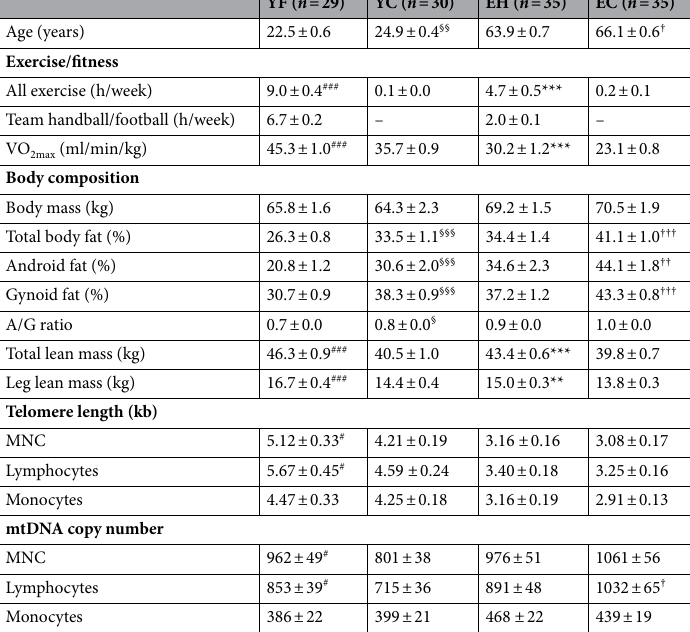
Table 1. Group characteristics in young football players (YF), young controls (YC), elderly team handball players (EH) and elderly controls (EC). Group means ± SEM. # p < 0.05, ### p < 0.001, higher than YC; § p < 0.05,